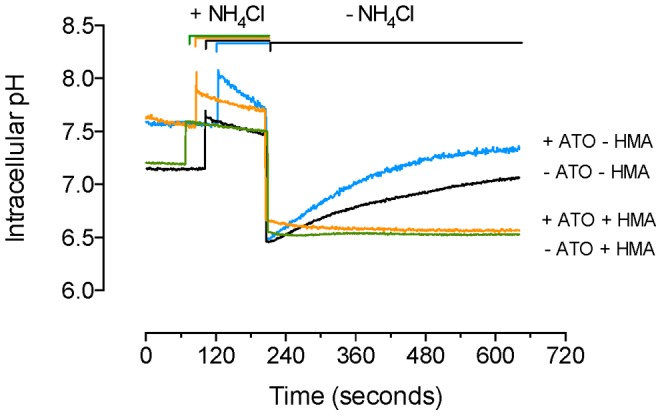
Effect of HMA on pHi recovery.MDCK cells were preloaded with BCECF-AM in the absence or presence of 0.05 µmol/L arsenic trioxide (ATO) dissolved in water. After transferring the cells into a spectrofluorometer the basal pHi was stabilized and then exposed (∼2 minutes) to a Na+-free solution containing 20 mmol/L NH4Cl (+NH4Cl). Cells were then rinsed with NH4Cl-free solution (–NH4Cl) and left in this medium without or with 5 µmol/L hexamethyleneamiloride (HMA) (see ). Methods). A representative record from other 18 different cell cultures is shown.